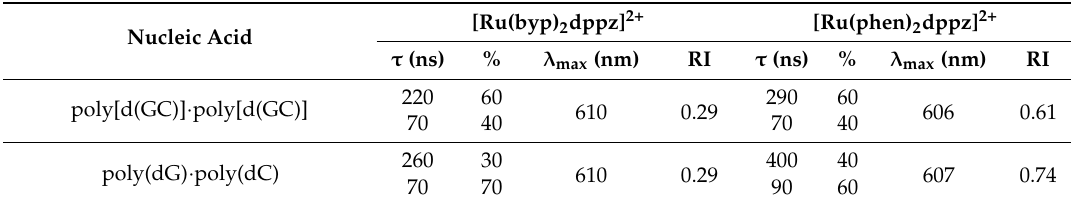
Table 1. Emission characteristics of [Ru(bpy) 2 (dppz)] 2+ and [Ru(phen) 2 (dppz)] 2+ upon binding to nucleic acids with different forms. Reproduced with permission from the authors of [13]. Copyright © 1992, American Chemical Society. RI: Relative emission intensity.